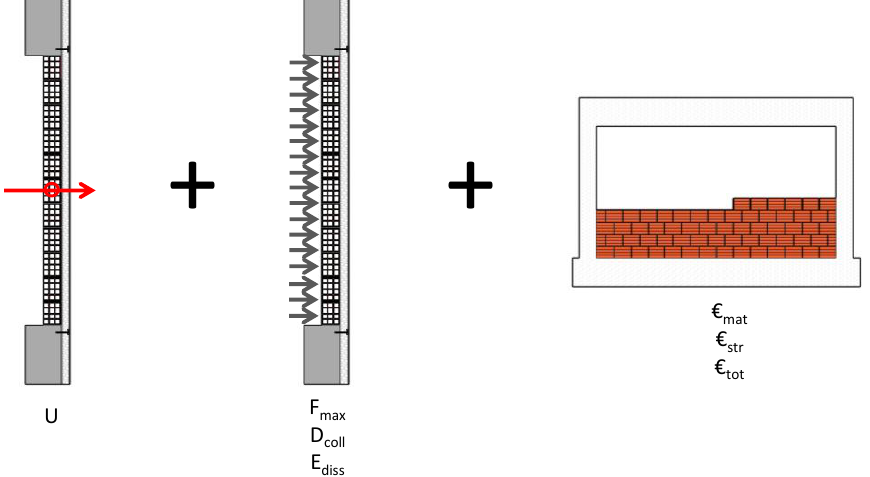
Figure 6. Holistic performance assessment flowchart.